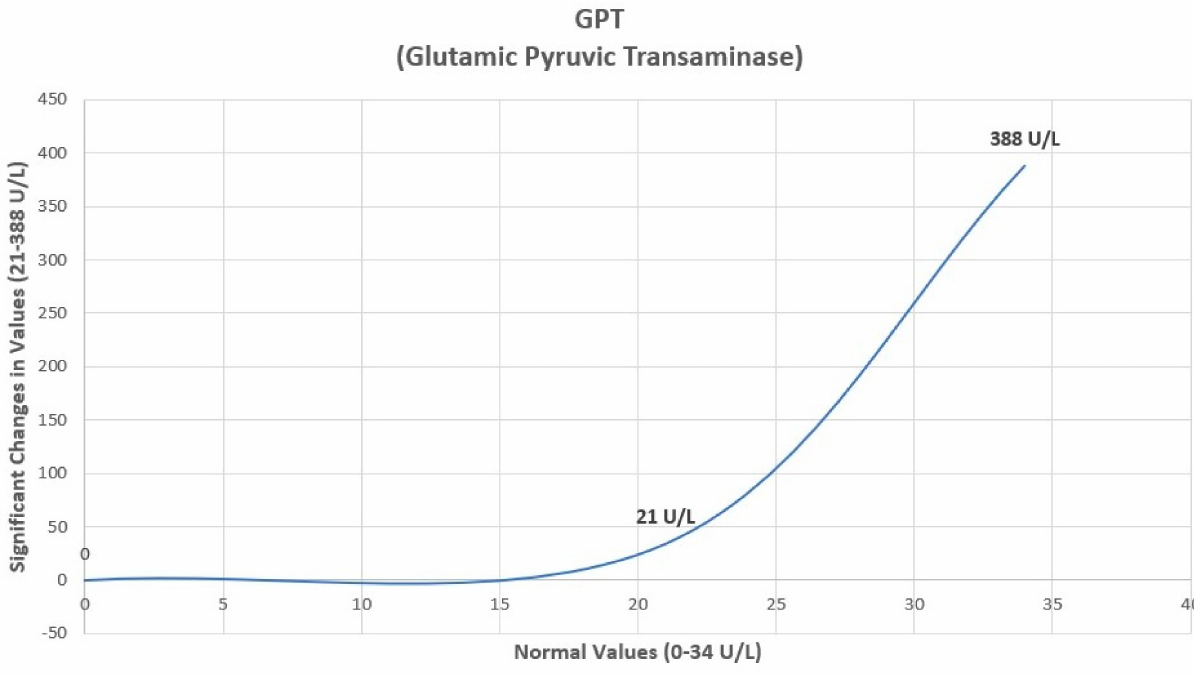
Figure 3. Significative changes in the GPT.